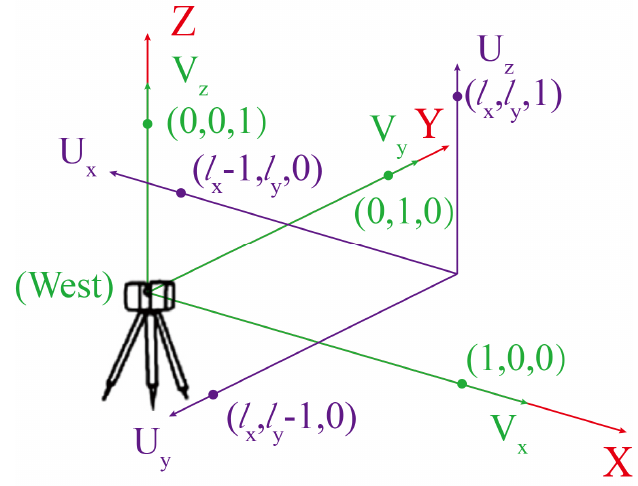
Figure 9. Final registered coordinate systems (the west–east case).